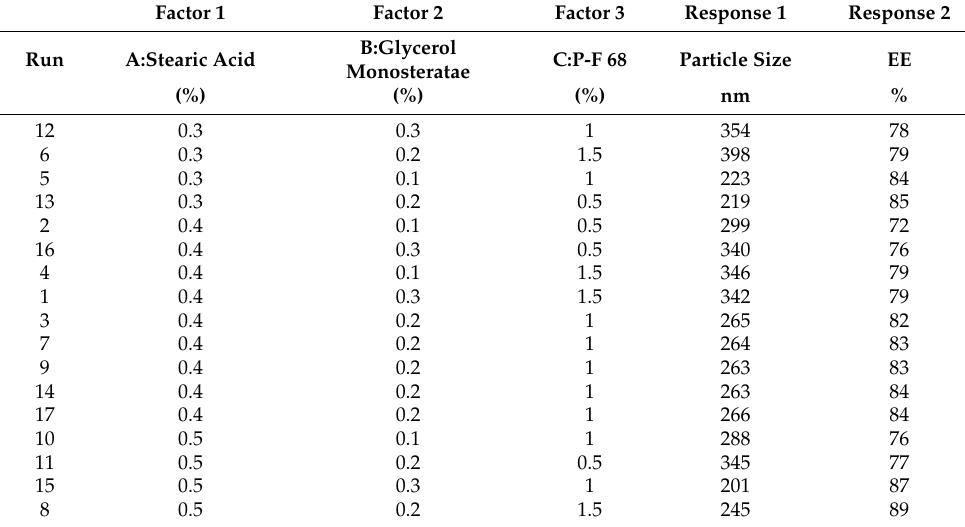
Table 1. Projected trial batches and their responses for central composite design.